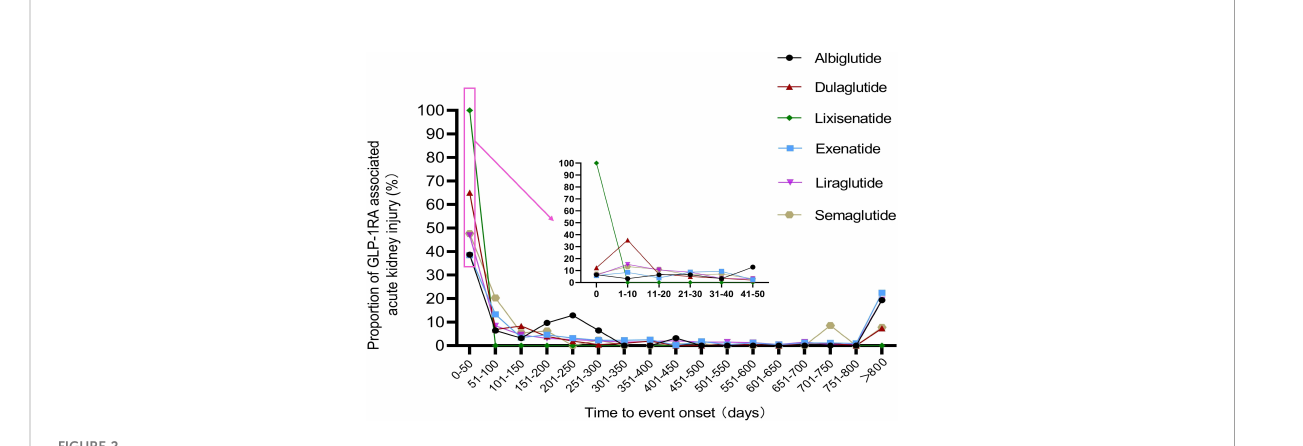
FIGURE 2 Distribution curve of the onset time of acute kidney injury caused by